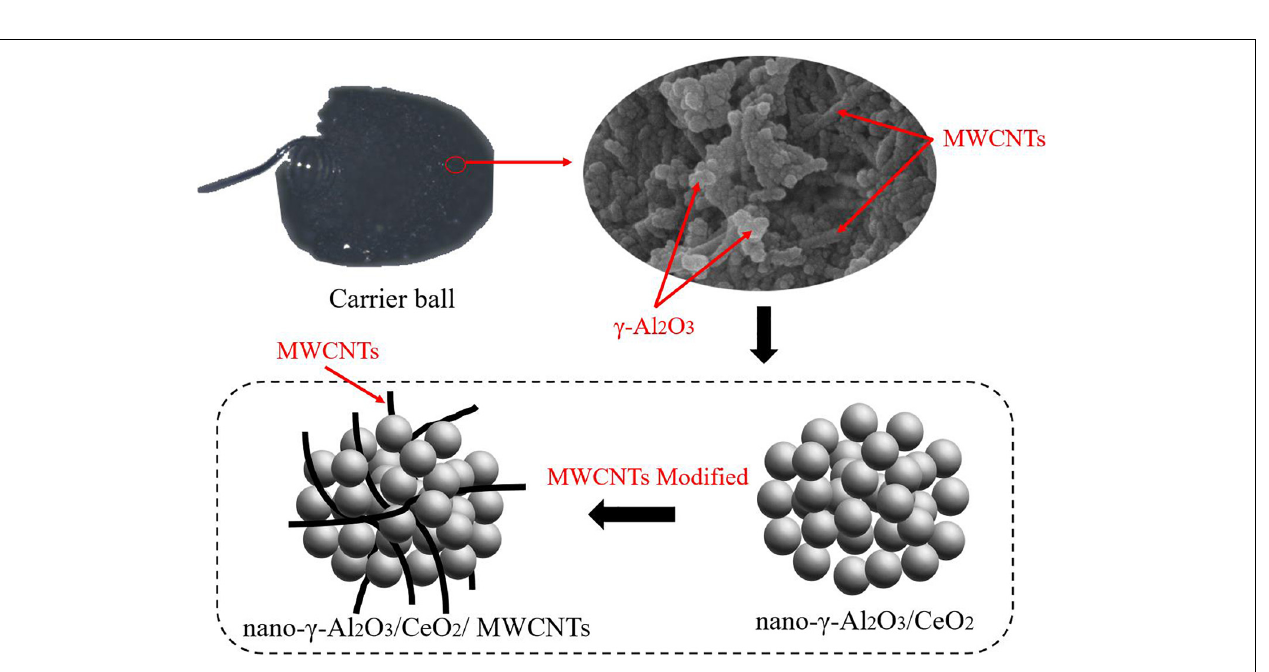
FIGURE 13 | Schematic diagram of doping MWCNTs